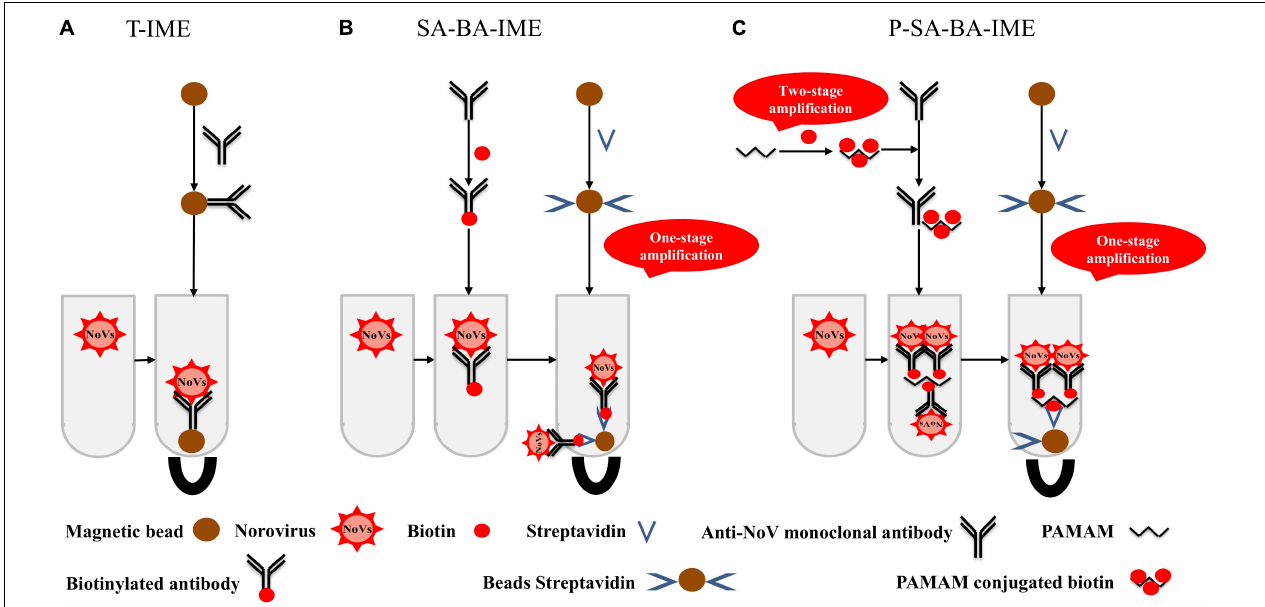
FIGURE 1 | Schematic illustration of (A) traditional immunomagnetic enrichment (T-IME), (B) streptavidin-biotin amplified IME (SA-BA-IME), and (C) polyamidoamine (PAMAM) dendrimer/SA-biotin mediated cascade-amplification IME (P-SA-BA-IME). In the T-IME method, antibodies are directly coupled on the surface of magnetic beads by covalent bonds to prepare immunomagnetic beads. In the SA-BA-IME system, the antibody is labeled with biotin to enrich the norovirus concentration in the sample, and then forms an immunomagnetic bead complex with streptavidin magnetic nanoparticles. Based on the P-SA-BA-IME, PAMAM is selected as the coupling carrier of biotin. The surface of PAMAM contains a large number of amino sites to perform the amplification of biotin.